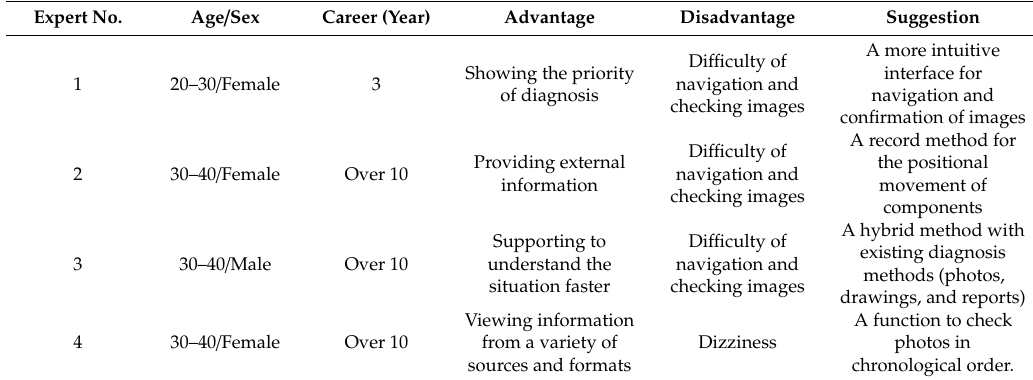
Table 3. Results of the focus-group interviews.